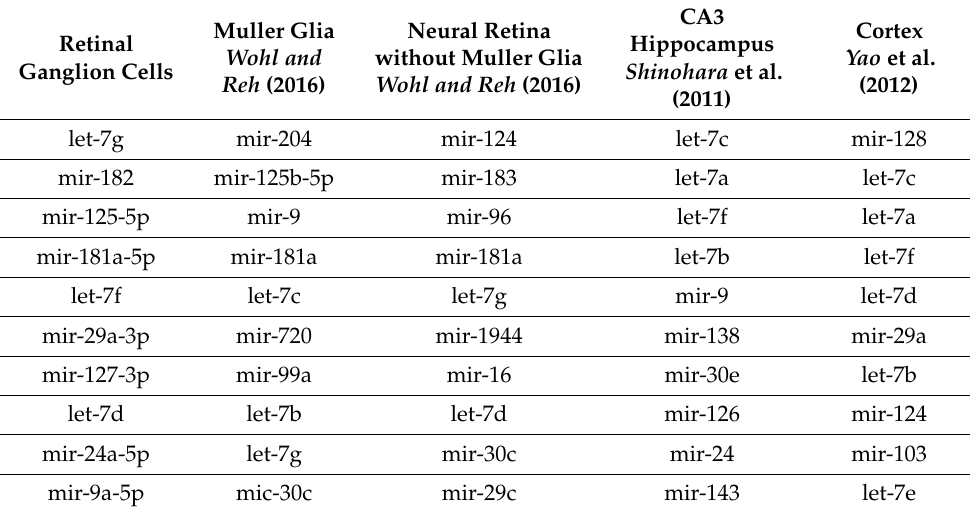
Table 1. The most abundant miRNA identified in retinal ganglion cells, Muller glia, neural retina, CA3 hippocampus, and cortex. The miRNA labelled in red are those unique to RGC and not found to be abundant in the other cell